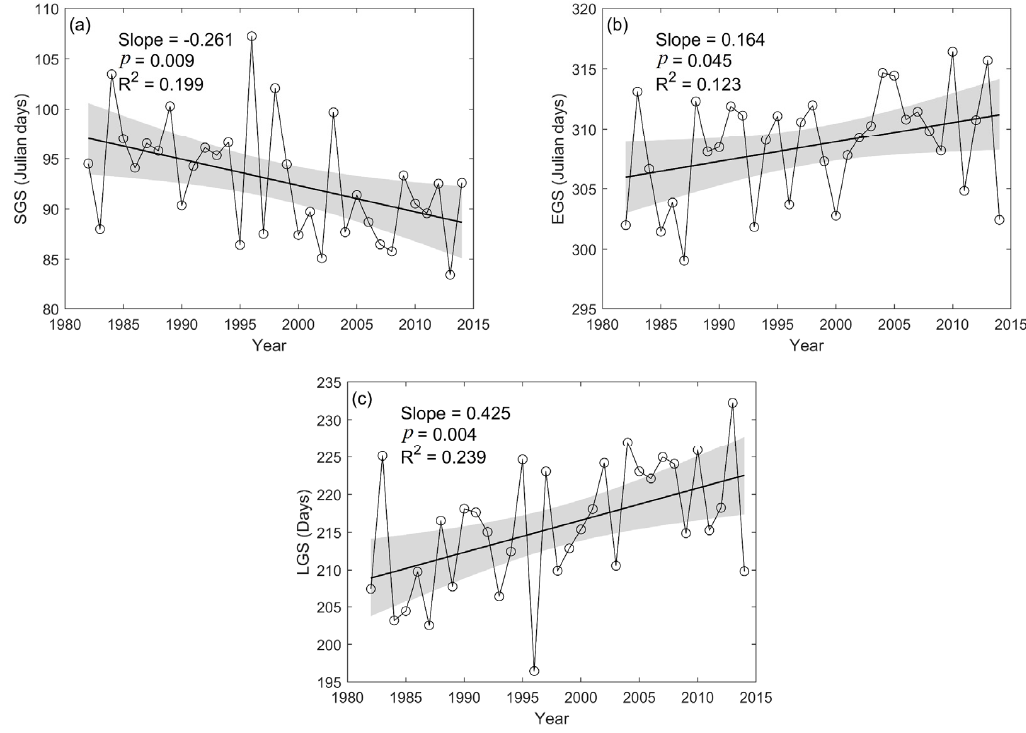
Figure 9. Interannual variations in ( a ) SGS, ( b ) EGS, and ( c ) LGS at a regional scale in the GLRCA during the period